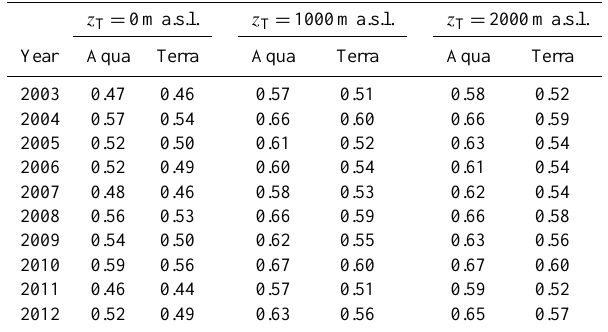
is covered by cloud for more than 90 % or for less than 20 %. The mode of the distribution can be estimated around 95